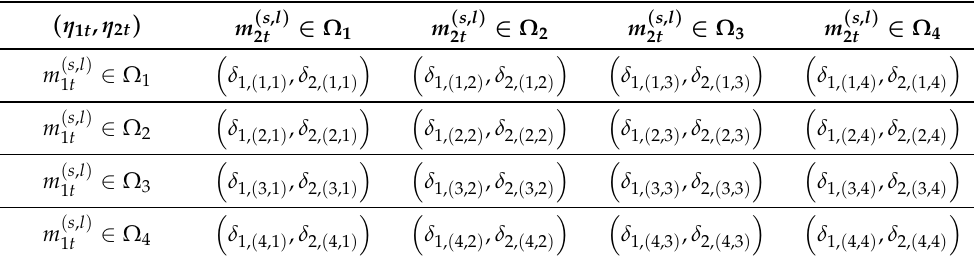
Table 2. MGMA strategy η t = ( η 1 t , η 2 t ) (cid:62) for a two-asset portfolio. ( η 1 t , η 2 t